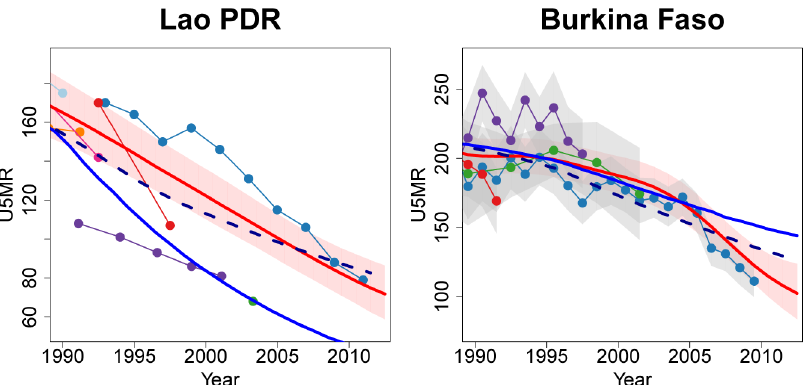
Figure 5. Comparison of U5MR estimates for Lao PDR and Burkina Faso where the change in database changed the estimate by more than 10 deaths per 1,000 live births. Estimates compared are from UN IGME 2013 (solid red line with 90% credible intervals given by the shaded regions), default Loess fit to 2013 database (dashed dark blue line) and UN IGME 2012 (solid dark blue line). Connected dots denote data from the UN IGME 2013 database and gray shaded areas around series of observations represent the sampling variability in the series (quantified by two times of the sampling standard errors). The newly-added/updated series for Lao PDR and Burkina Faso are those shown in dark blue. Excluded data series and detailed information on all data series are displayed in Figure S1.